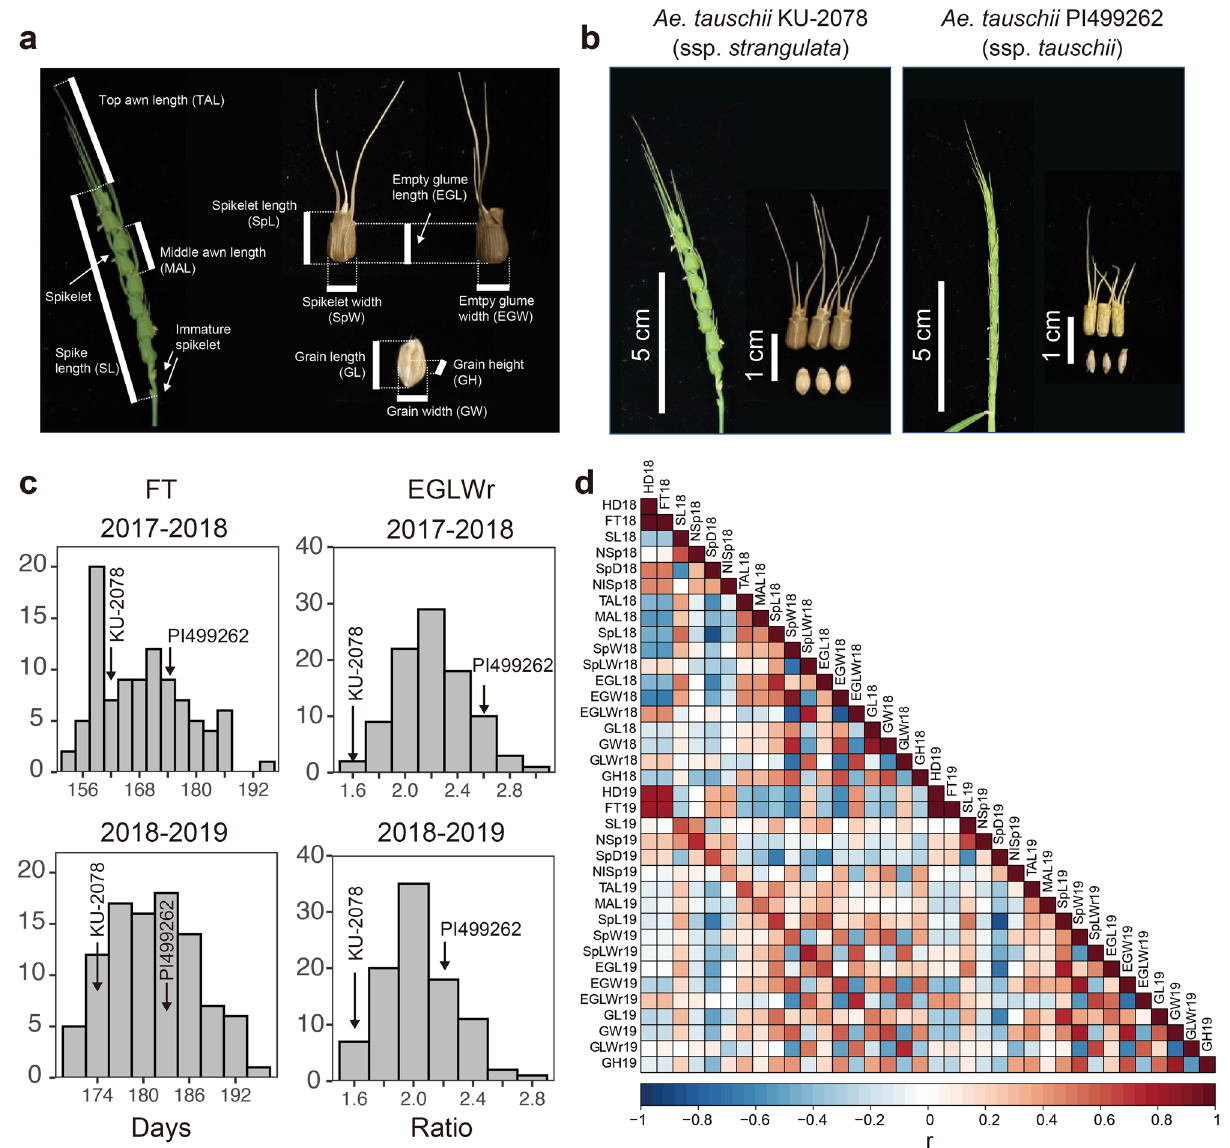
Figure 2. Evaluation of traits for Ae. tauschii KU-2078/PI499262 RILs and their parental accessions. ( a ) Measured spike, spikelet and grain traits. ( b ) Spike, spikelet and grain morphologies of the parental accessions. Ae. tauschii ssp. strangulata forms quadrate spikelets, while the spikelets of Ae. tauschii ssp. tauschii are elongated and cylindrical. ( c ) Histograms of flowering time (FT) and the empty glume length-to-width ratio (EGLWr) in Kobe, Japan, in the 2017–2018 and 2018–2019 seasons. ( d ) Pearson’s correlation coefficient (r) between the tested traits in the RILs in the two seasons. HD Heading date, NSp number of spikelets, NISp number of immature spikelets, SpD Spikelet density, SpLWr spikelet length-to-width ratio, GLWr grain length-to-width ratio. The histograms and the heatmap were created with the R packages ggplot2 (Wickham 2016) and corrplot (Wei and Simko 2017),